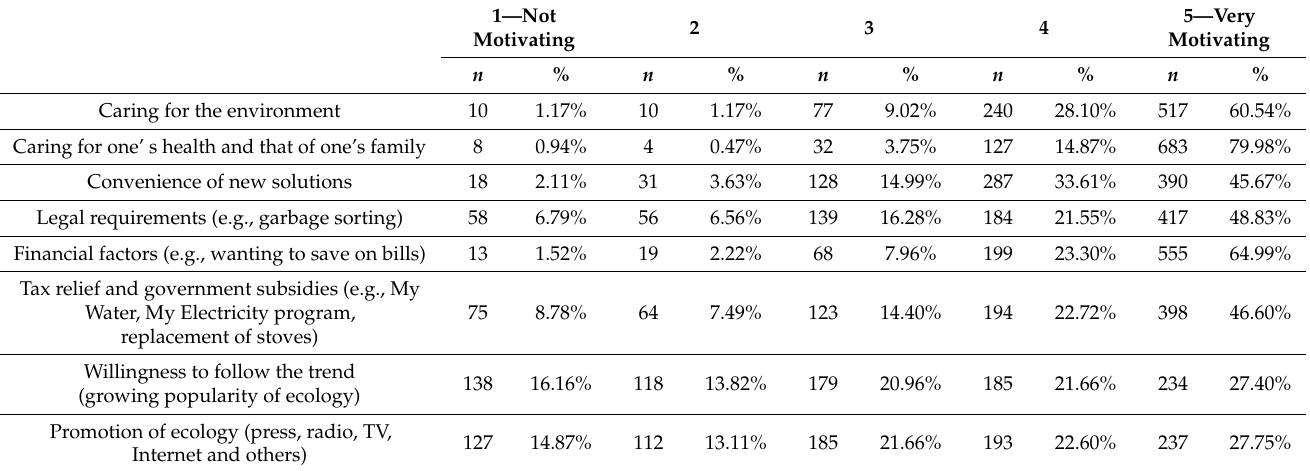
Table 5. Factors motivating the respondents to engage in pro-ecological